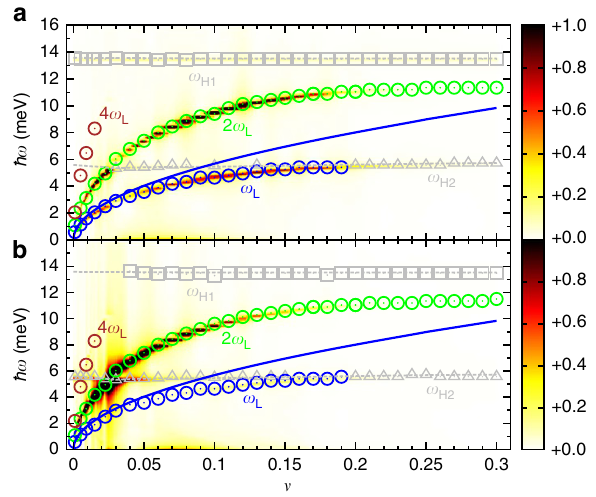
Figure 4 | Amplitude mode oscillations versus relative interband coupling. Fourier spectrum of the amplitude mode oscillations as a function of relative interband coupling u for ( a ) the superconducting gap D 1 in the first band and ( b ) the superconducting gap D 2 in the second band. The parameters of the laser pump pulse are the same as in Fig. 2. The amplitude of the oscillations is indicated by the colour scale with dark red and light yellow representing the highest and lowest amplitudes, respectively. The open circles represent the frequencies of the non-equilibrium Leggett mode o L and its higher harmonics denoted by 2 o L and 4 o L . The frequencies of the non-equilibrium Higgs mode of the first and second band, o H1 and o H2 , are indicated by the grey open squares and triangles, respectively. The blue solid line is the frequency of the equilibrium Leggett mode given by equation (2).